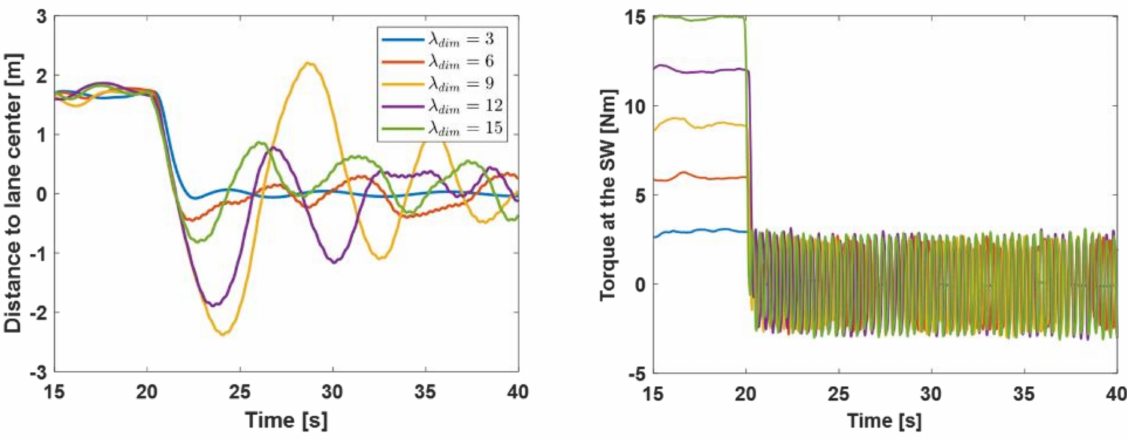
Figure 3. Stability test with constant damping ( b